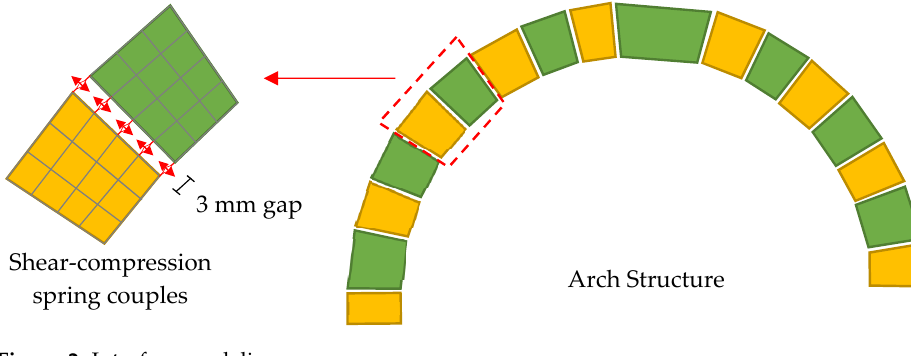
Figure 2. Interface modeling.